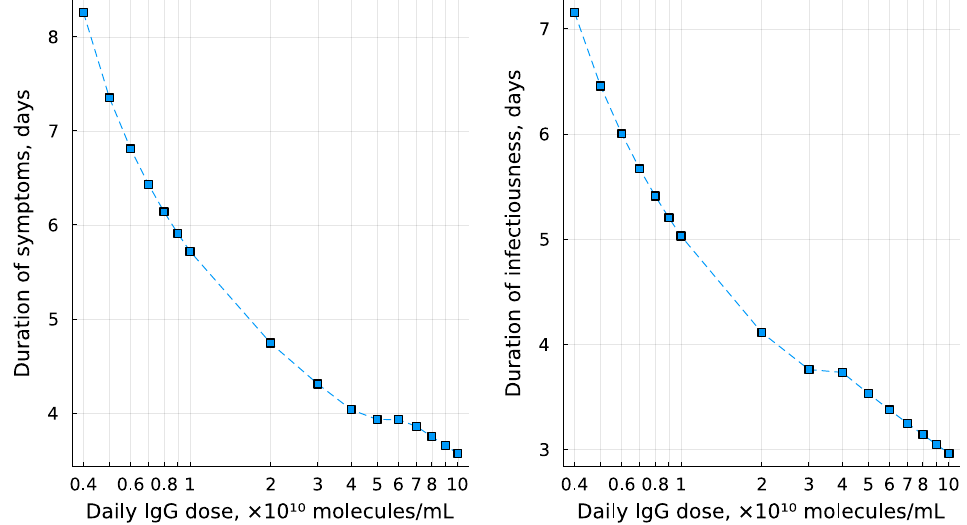
Figure 18. The predicted effect of immunoglobulins-based treatment on the duration of symptoms ( left ) and the period of viral load above the infectiousness threshold ( right ). The simulations consider daily injection of virus-specific IgG at doses ranging from 0.4 × 10 10 to 10 11 molecules/mL starting from day 2 post establishment of symptoms during 5 days treatment